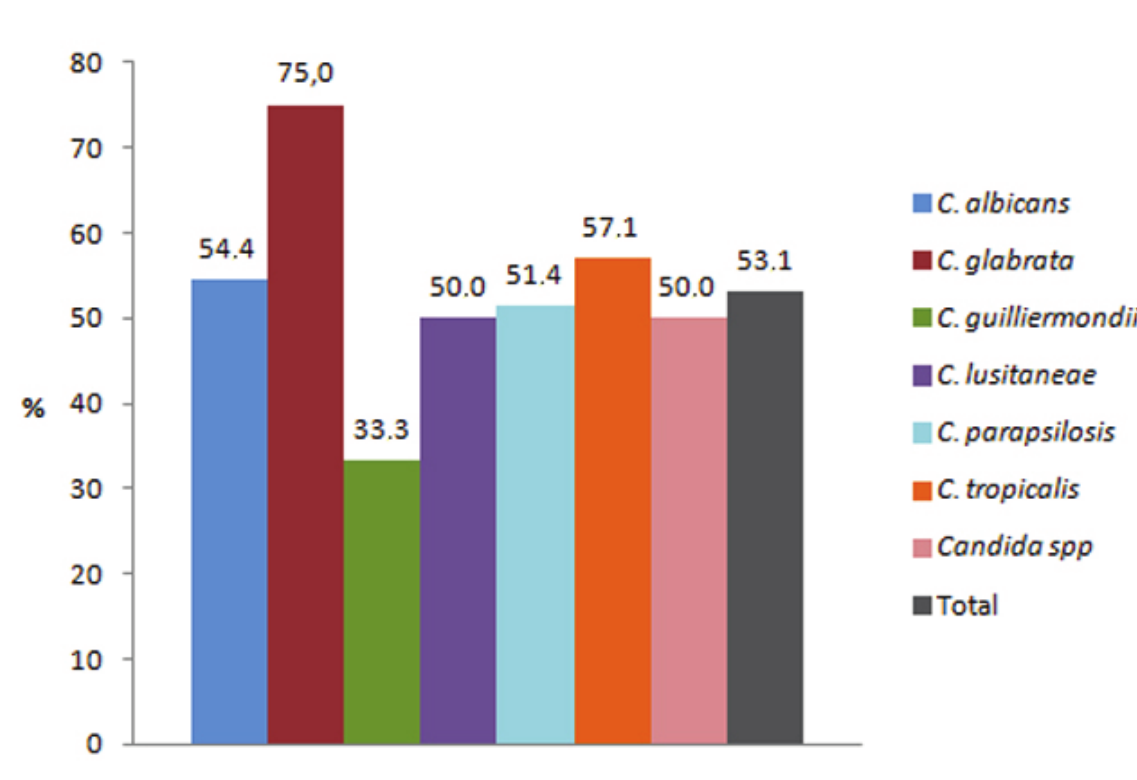
Figure 2. Mortality distribution by